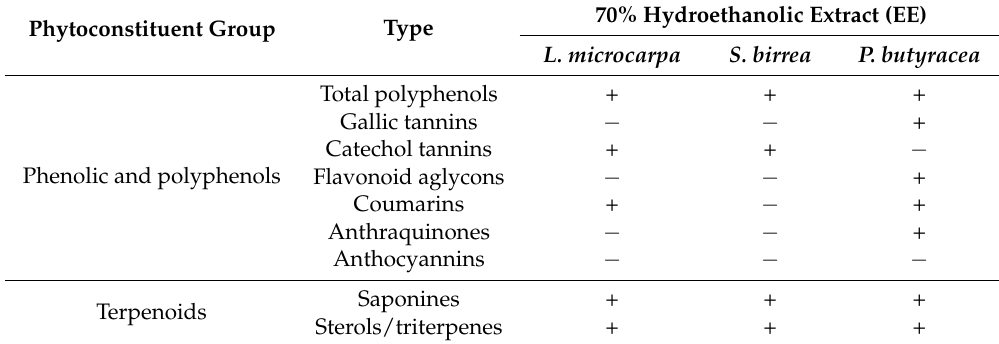
Table 4. Identification test results for the phytoconstituent groups.